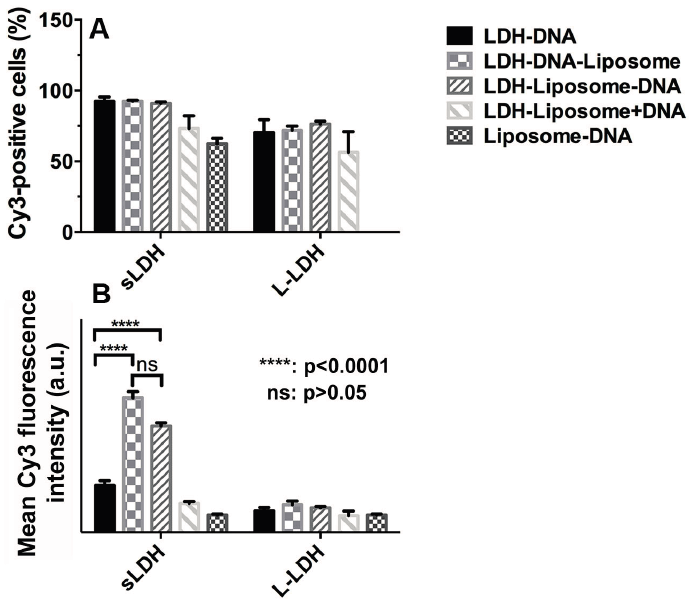
Figure 6. Cellular uptake of DNA–Cy3 by HCT-116 cells in terms of Cy3-positive cell percent ( A ) and mean Cy3-fluorescence intensity ( B ) (20 nM DNA, LDH:DNA mass ratio = 20:1, EPC:DNA = 20:1 and 4 h